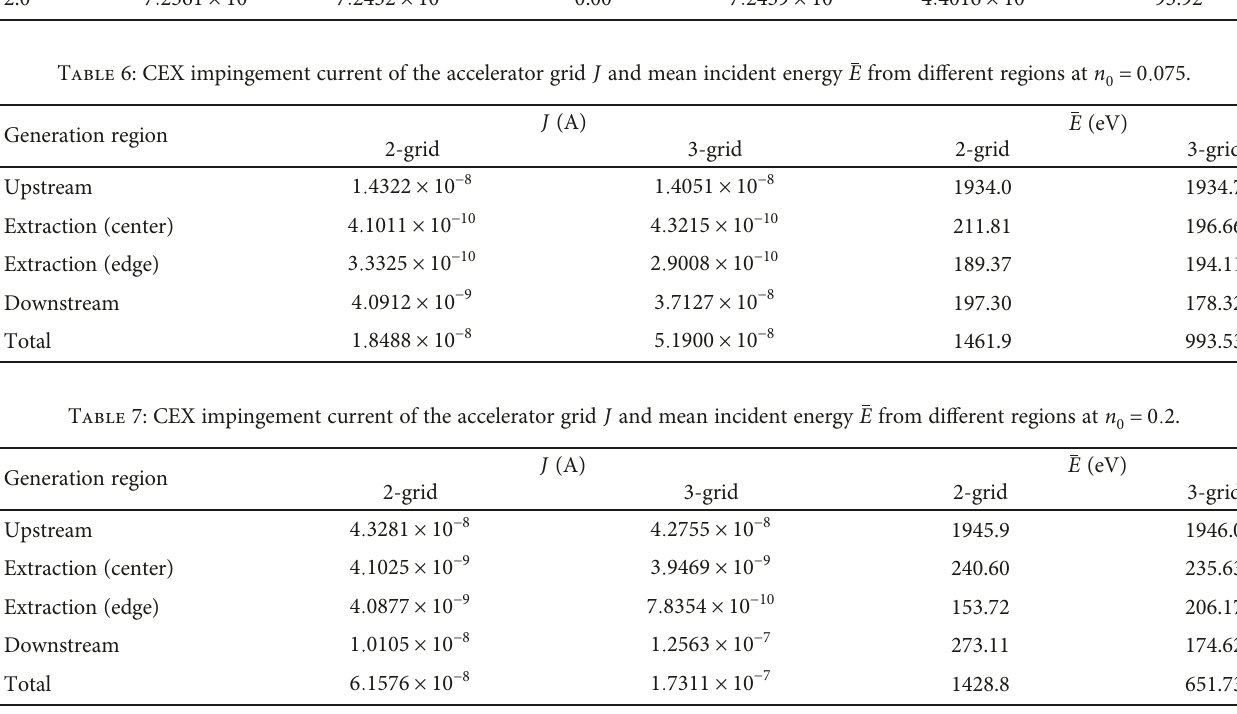
Table 8: CEX impingement current of the accelerator grid J and mean incident energy E from di ff erent regions at n Generation region